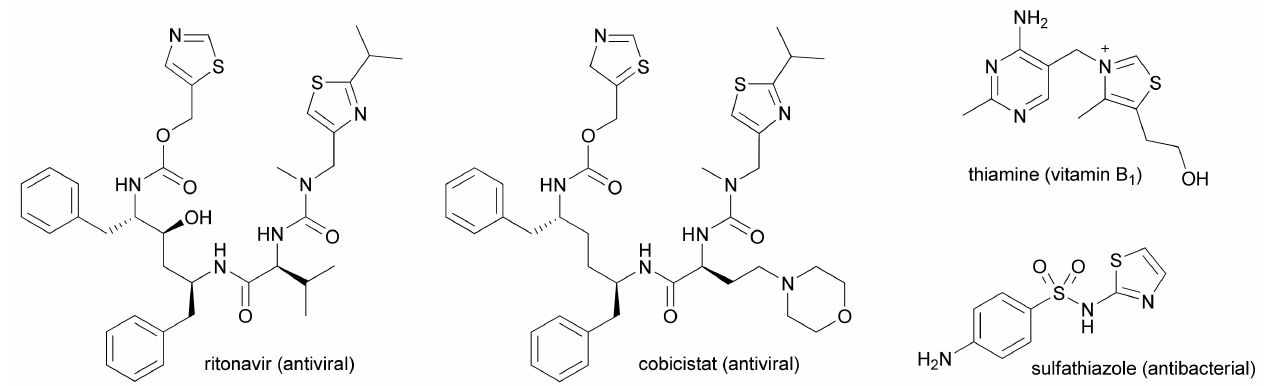
Figure 1. Natural and synthetic drugs containing thiazole